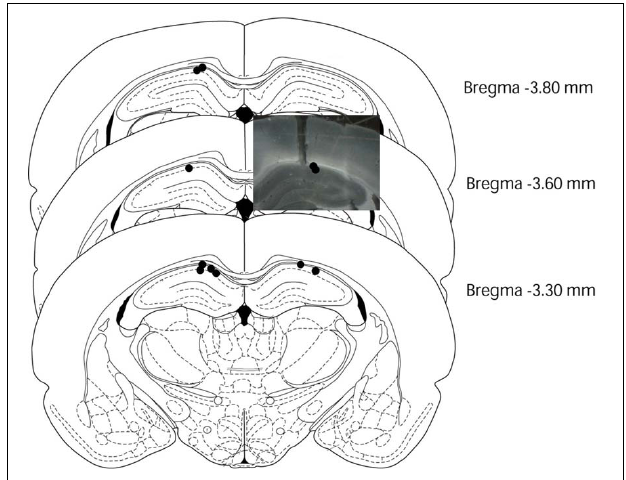
FIGURE 1 | Electrode placements in the rat brains. This figure was modified from Paxinos and Watson (1997). Black circles and photo data indicated the placement of the electrode tips in each rat ( n = 12